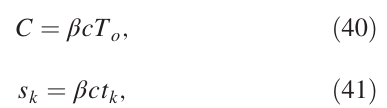
FIG. 15. The normalized error function β (bottom) for ten irregular BPMs (blue circles) and ten x regular BPMs (orange squares). The average value of